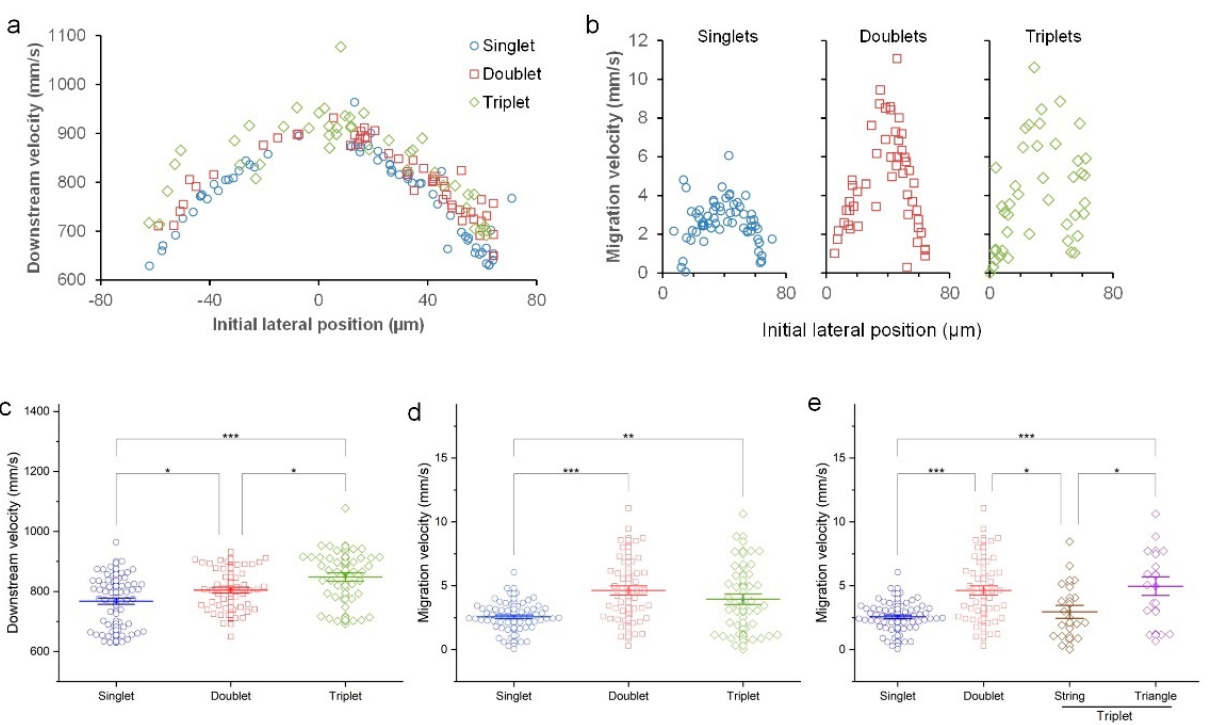
Figure 6. Downstream velocity and lateral migration velocity: ( a ) Downstream velocity of all singlets, doublets, and triplets resembling the parabolic velocity profile of the channel flow; ( b ) Migration velocity of singlets, doublets, and triplets depending on initial lateral position; ( c ) Downstream velocity comparison of single cells, doublets, and triplets; ( d ) Doublets and triplets migrate faster than singlets in general while no significant difference in migration velocity of doublets and triplets are found; ( e ) Triangle triplets migrate faster than string triplets and singlets in general. N = 66, 51, 43, 20, 17 for single cells, doublets, triplets, string triplets, and triangle triplets, respectively. Additionally, 6 of the 43 triplets were excluded from comparison in ( e ) as they were in a hybrid format (changing from string to triangle from time to time). * p < 0.05, ** p < 0.01, *** p < 0.001.